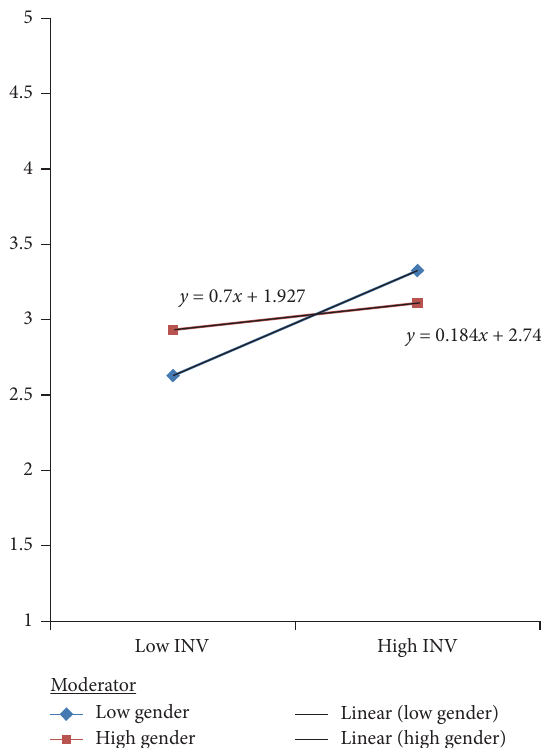
F IGURE 6: Graphical representation of interaction effect between RTP and e-EI. Gender dampens the positive relationship between RTP and e-EI. Source: calculated by authors based on Lowry and Gaskin [64].